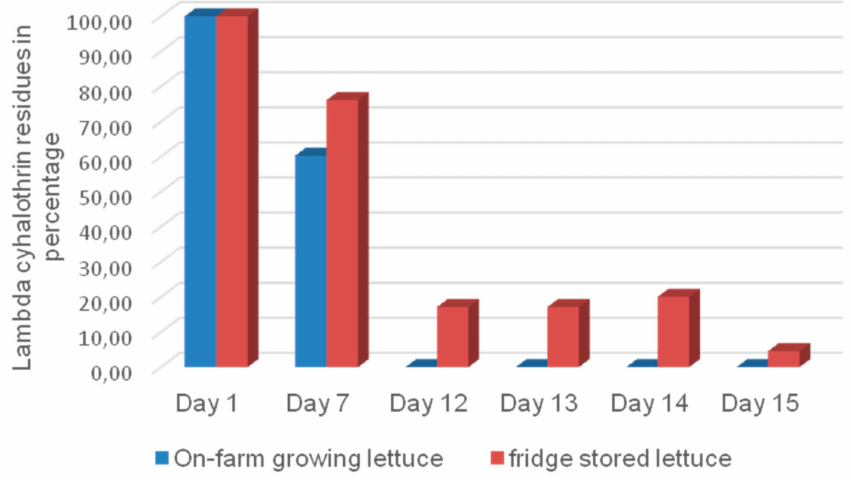
Figure 6. Distribution of λ -cyhalothrin residues on growing lettuces compared to fridge-stored